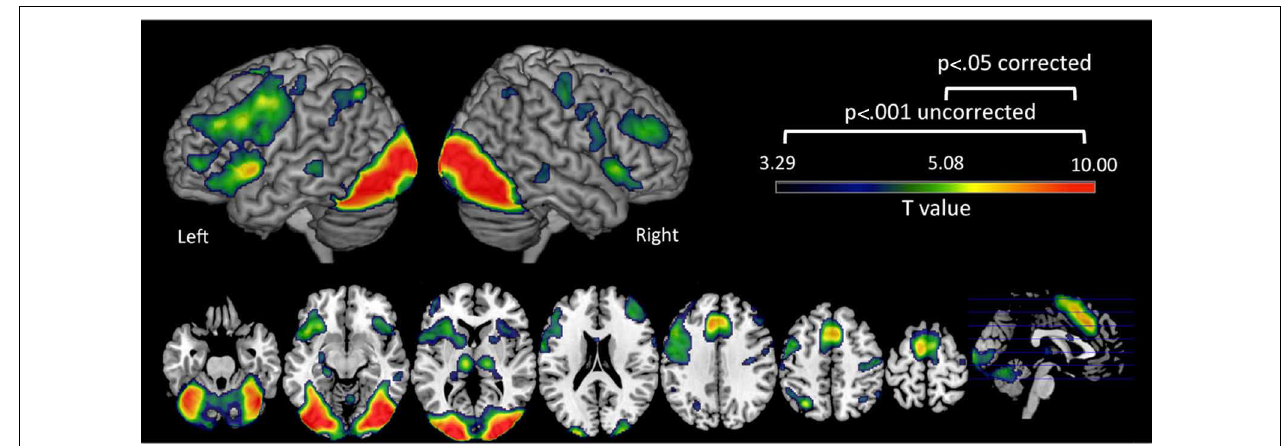
uncorrected, cluster extent = 10 are also included to show the extent of these clusters at a more lenient threshold. Note: Left Hemisphere is shown on left side.